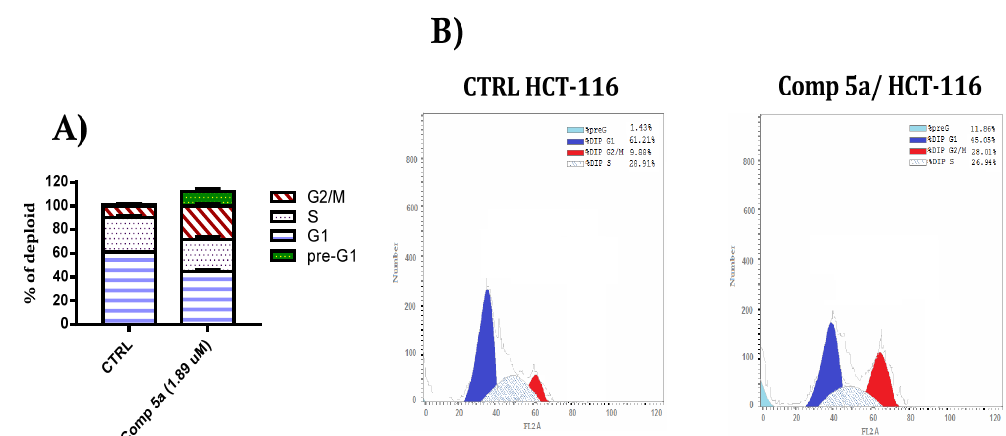
Figure 2. ( A ) Graphical representation of cell cycle distribution of HCT-116 cell line induced by compound 5a . ( B ) Cell cycle distribution of HCT-116 cell line induced by compound 5a .